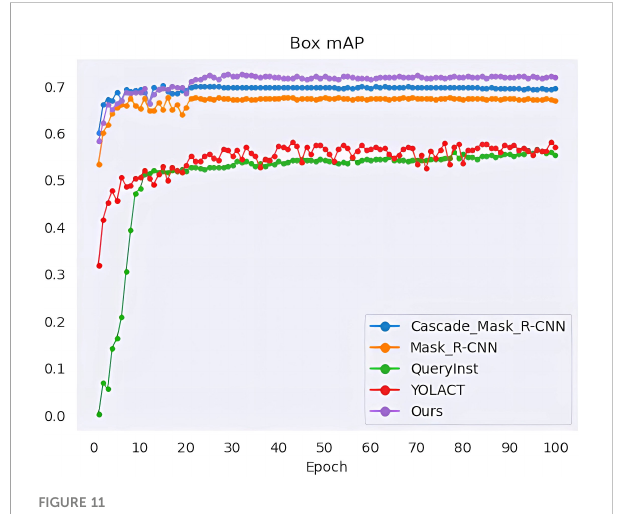
FIGURE 11 Box detection mAP of the